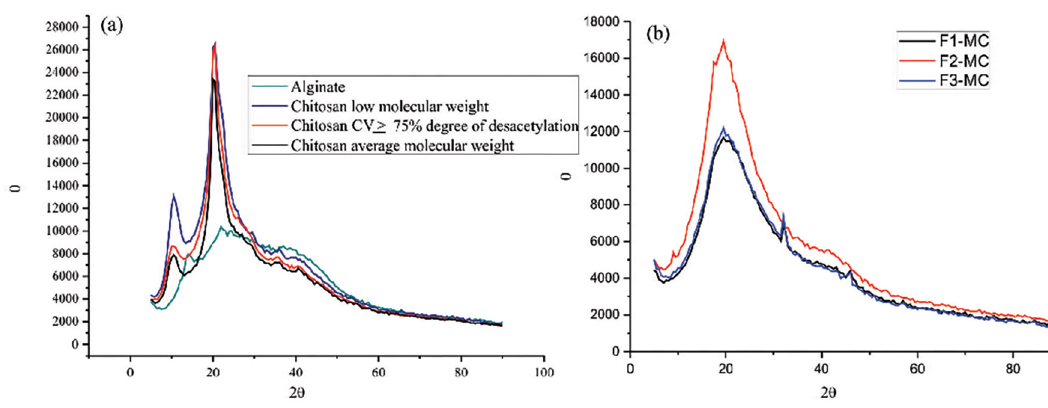
FIGURE 4 - X-ray diffraction of polymers (a), and from FHPp-loaded microcapsules (b). Similar results have been observed by other authors (Lawrie et al ., 2007; Pasparakis, Bouropoulos, 2006). According to Czubenko and Druzynska (2009), the vibrations at 2931 cm -1 are attributable to an aliphatic C-H stretch.